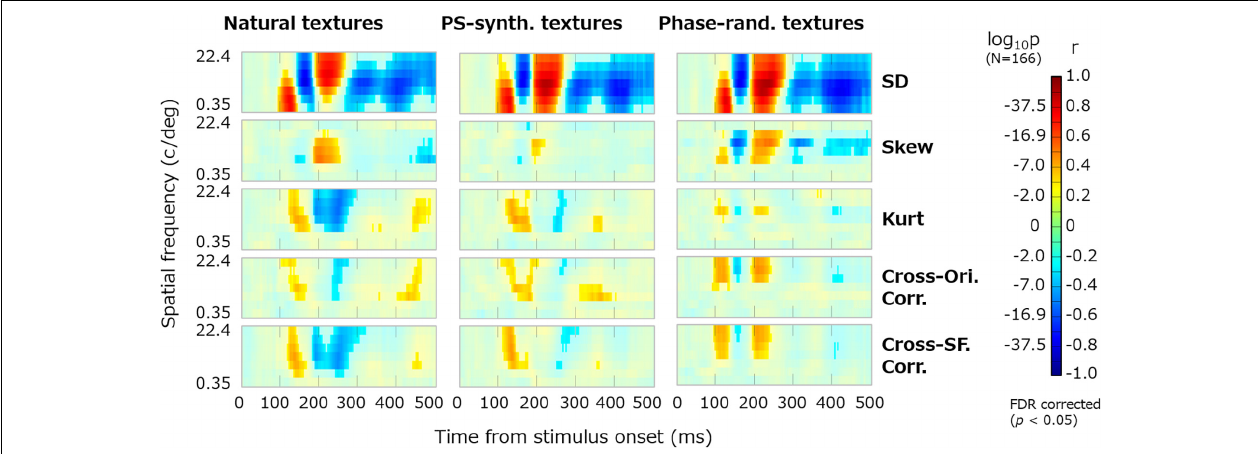
FIGURE 5 | Dynamics of VEPs correlated with summary image statistics. The horizontal axes represent the time from the stimulus onset (0–496 ms) and the vertical axes represent the spatial frequency (c/deg). Reddish pixels indicate positive correlation and blueish pixels indicate negative correlation, for which non-significant data ( p ≥ 0.05, FDR corrected) are desaturated. Panels in the successive rows show the correlations of VEPs with the SD, skew, kurtosis, and cross-orientation energy correlation and cross-frequency energy correlation. The results are shown for natural textures (left), PS-synthesized textures (middle), and phase-randomized textures